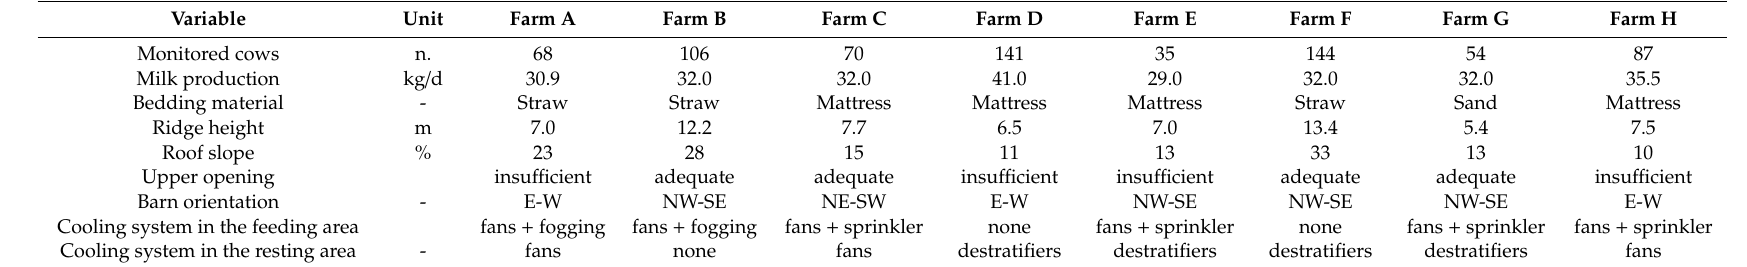
Table 1. Main characteristics of the monitored